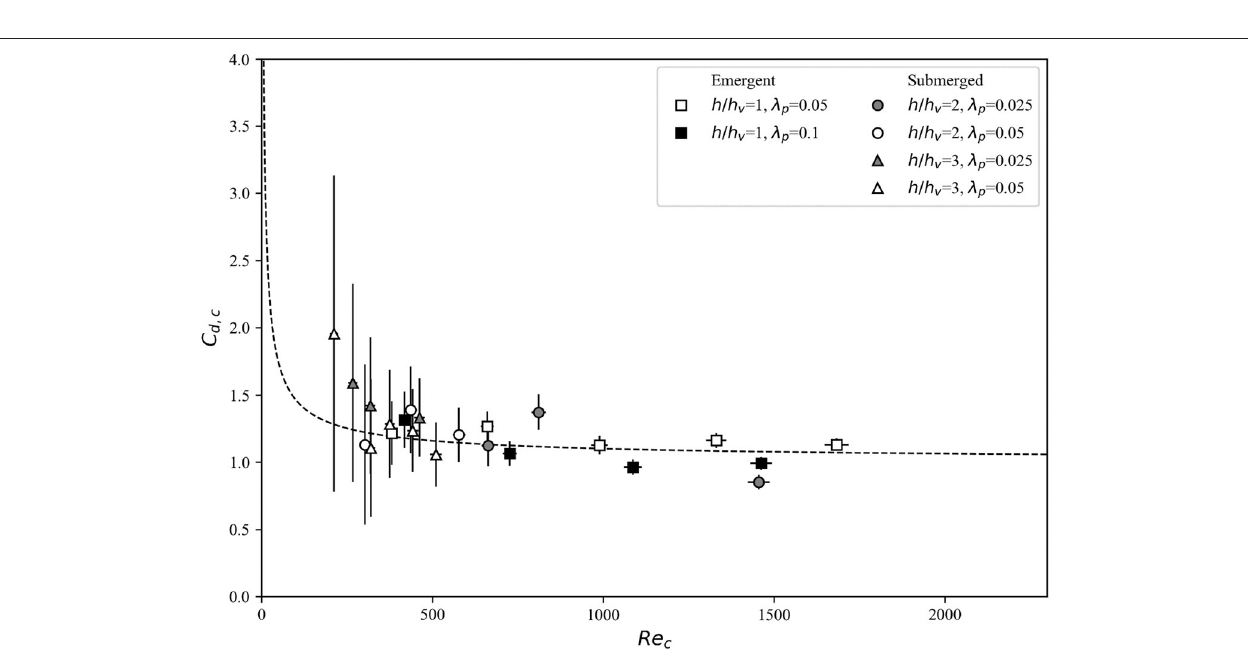
FIGURE 7 | Drag coefficients derived from the drag force measurements for all canopies using the constricted cross-section velocity U c as the reference velocity for the emergent and submerged cases. Theoretical values for the drag coefficient of an isolated cylinder (Equation 2) are denoted by the dashed line.